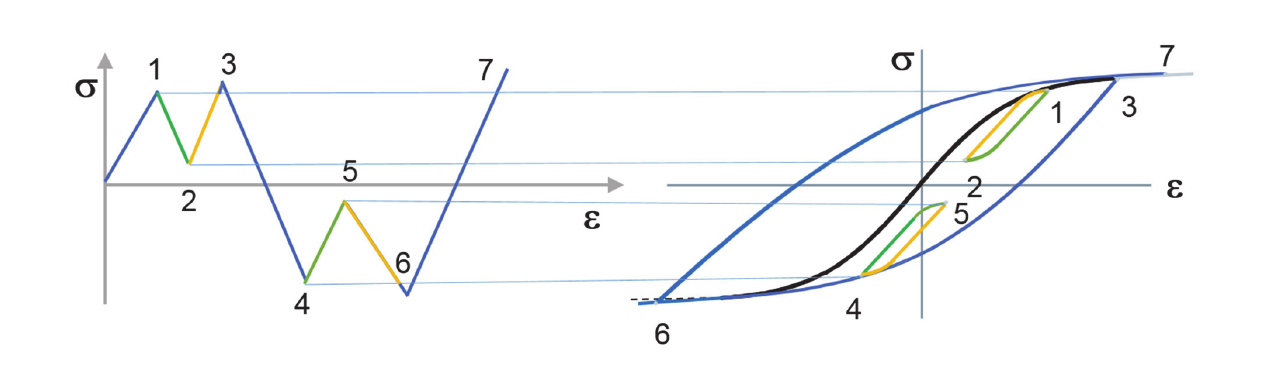
Figure 3. Illustration of rainflow method based on stresses/strains with nested cycles.